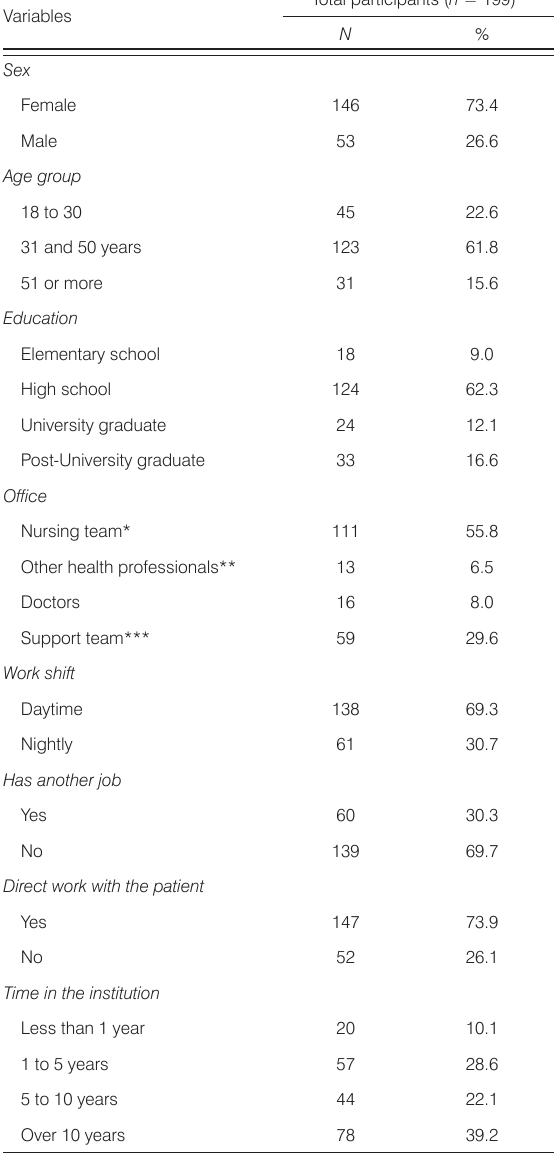
Table 1. Sociodemographic and employment data for multidisciplinary team member